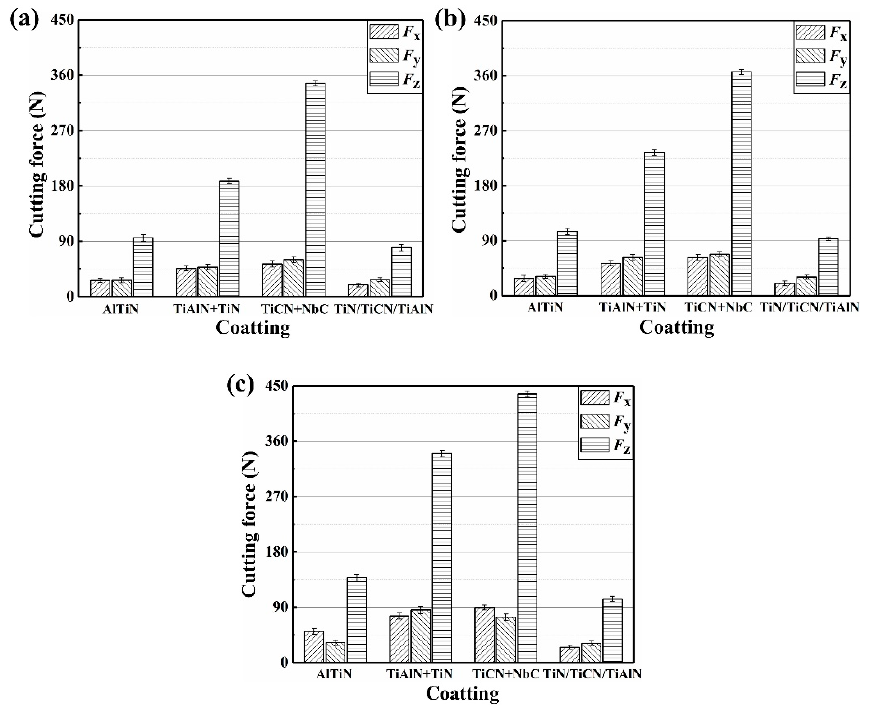
Figure 4. Effect of coatings on cutting force at ( a ) v c = 280 m/min, ( b ) v c = 360 m/min, and ( c ) v c = 440 m/min, f z = 0.02 mm/z, a p = 0.2 mm, and a e = 2 mm.